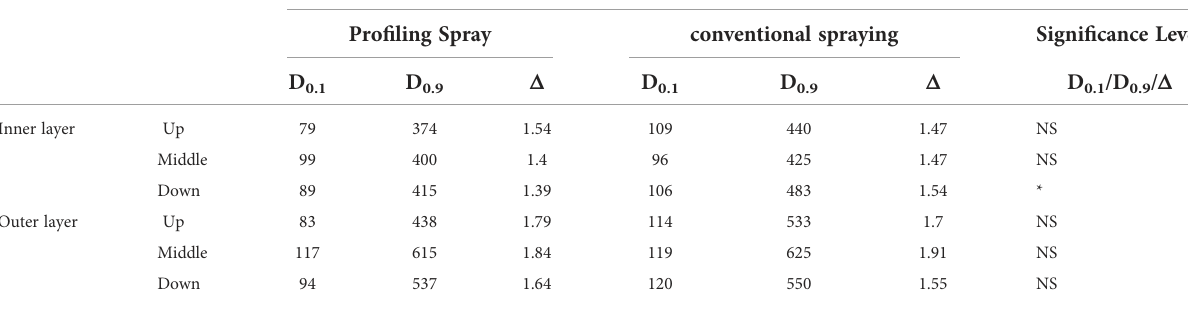
TABLE 5 Relative span coef fi cient results of pro fi le variable spray and traditional spray. Zone of the tree